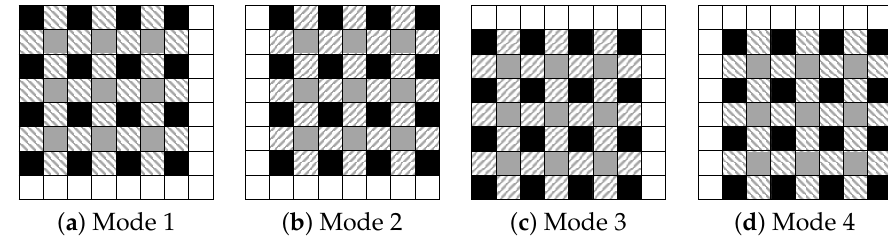
Figure 2. Four prediction modes.